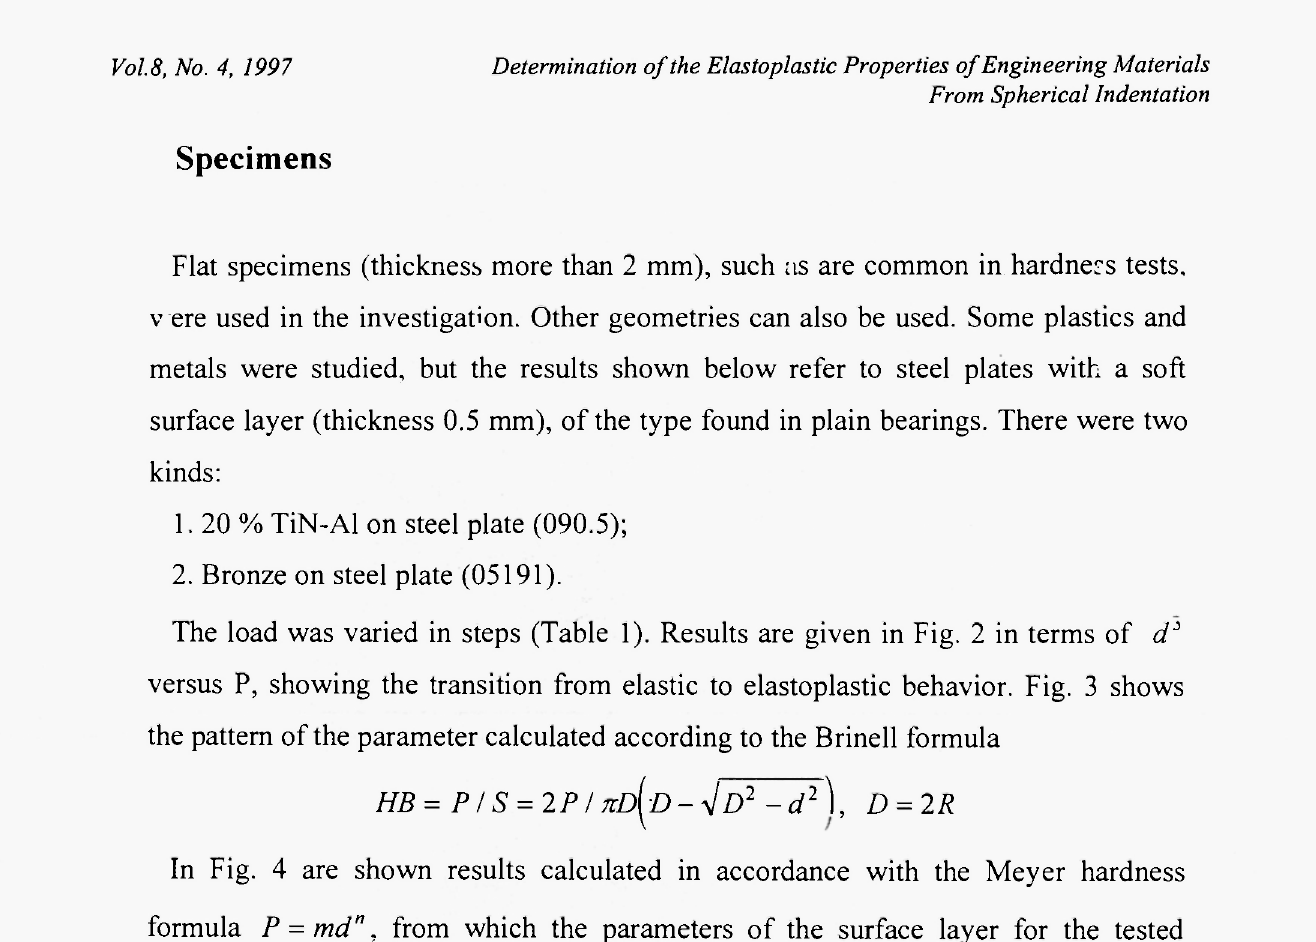
Table 1. Dependence of the contact circle diameter on load